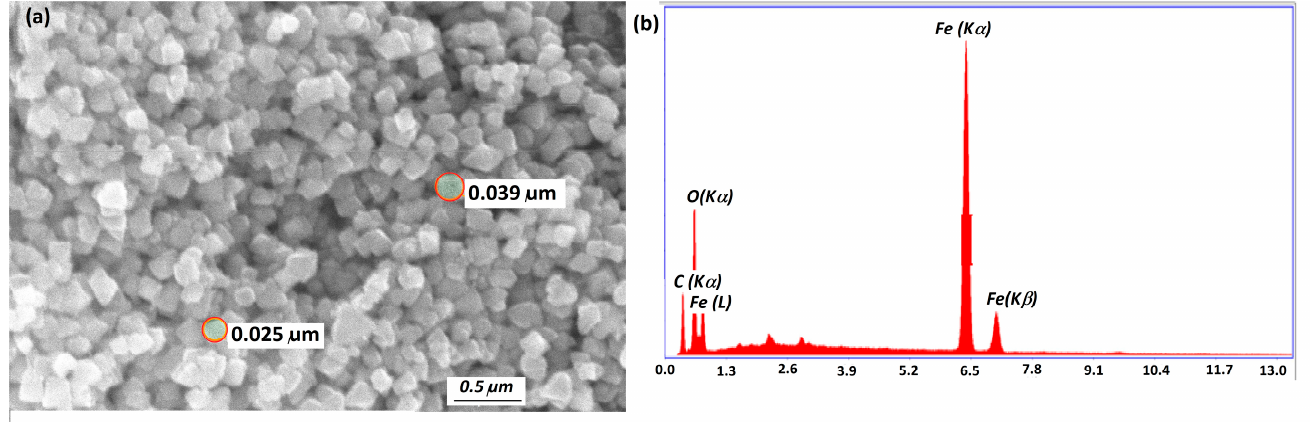
Figure 4. ( a ) SEM image and ( b ) EDS mapping analysis of m-CGPA.